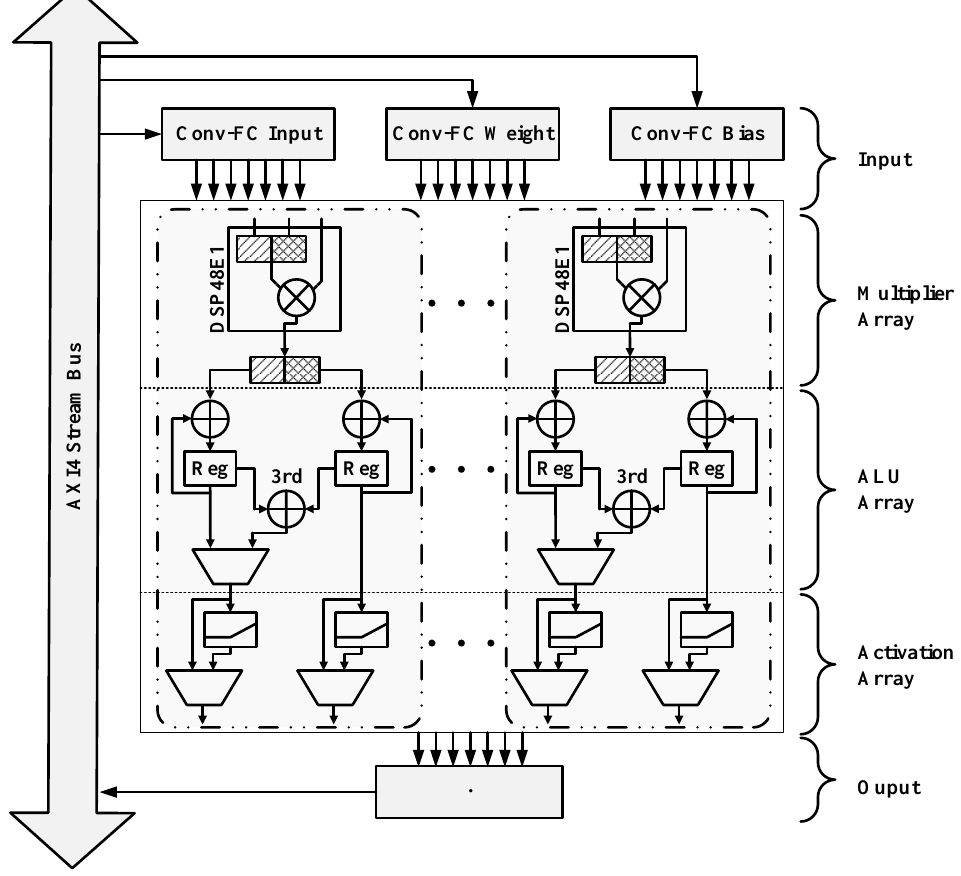
Figure 13. Convolution acceleration module.